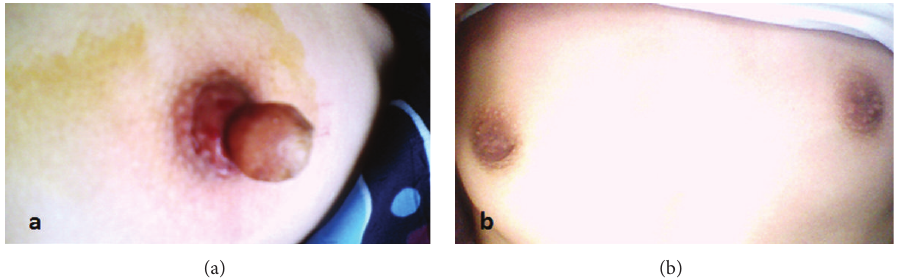
Figure 1: (a) The appearance before excision. (b) The appearance six months after excision.